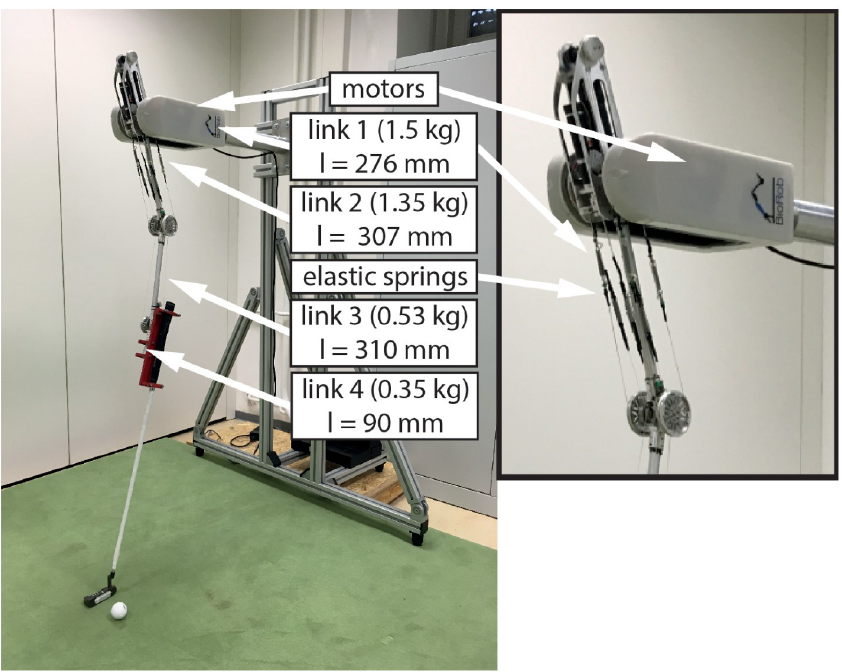
Fig 1. BioRob-system. BioRob with 4 DOF on a movable lightweight frame construction for experiments.